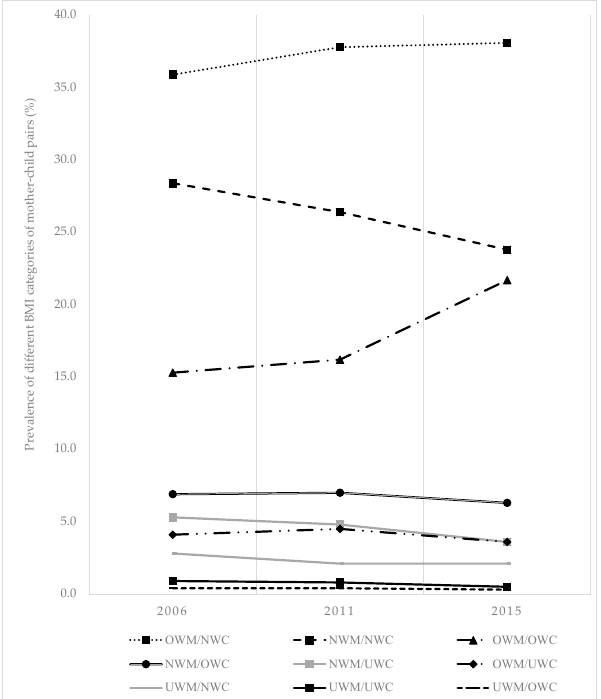
Figure 1. Prevalence of different BMI categories of mother–child pairs (UWM/UWC = underweight mother/underweight child; UWM/NWC = underweight mother/normal weight child; UWM/OWC = underweight mother/overweight child; NWM/UWC = normal weight mother/underweight child; NWM/NWC = normal weight mother/normal weight child; NWM/OWC = normal weight mother/overweight child; OWM/UWC = overweight mother/underweight child; OWM/NWC = overweight mother/normal weight child; OWM/OWC = overweight mother/overweight child).